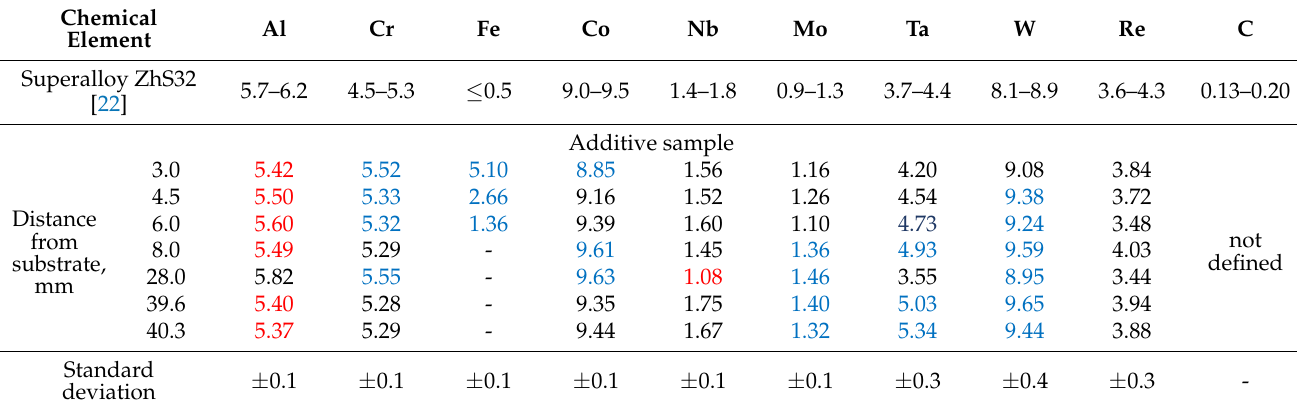
Table 3. Chemical composition (% wt.) of material additive component from nickel-based superalloy ZhS32. The colors show the underestimation of the brand composition of the regulated values in red and the overestimation in